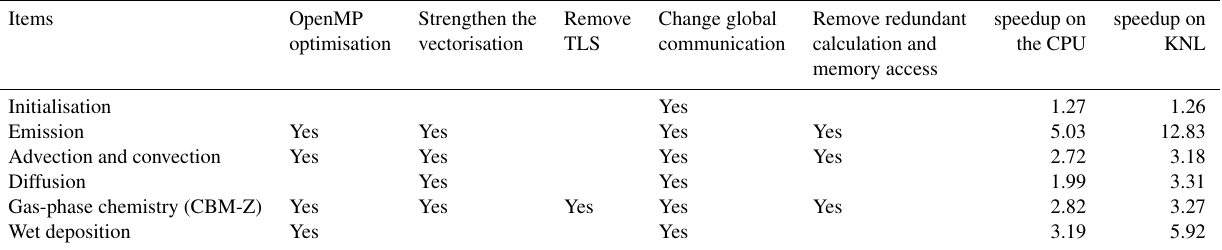
Table 2. Optimisation measures for the main modules and the speedup after the optimisation on the CPU and KNL platforms. The well- parallelised modules (e.g. emission module) could get a high speedup of 12.83 × on KNL, and a 3.27 × speedup on KNL and 2.82 × speedup on the CPU were achieved for the CBM-Z gas-phase chemistry module, which was the most time-consuming part (68%) for the baseline